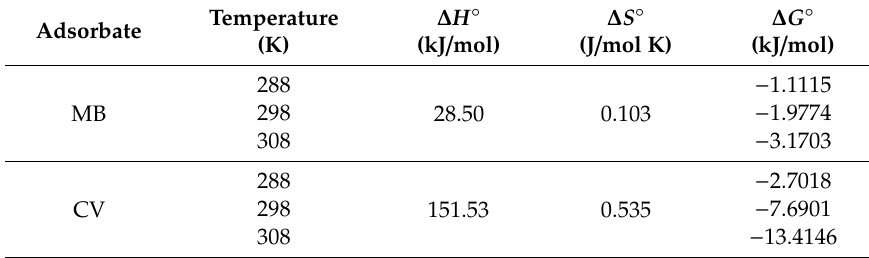
Table 4. Thermodynamic parameters for adsorption of methylene blue (MB) and crystal violet (CV) on rice husk. ∆ H ◦ : the change in enthalpy (kJ / mol); ∆ S ◦ : the change in entropy (J / mol K); ∆ G ◦ : the change in Gibb’s free energy (kJ /